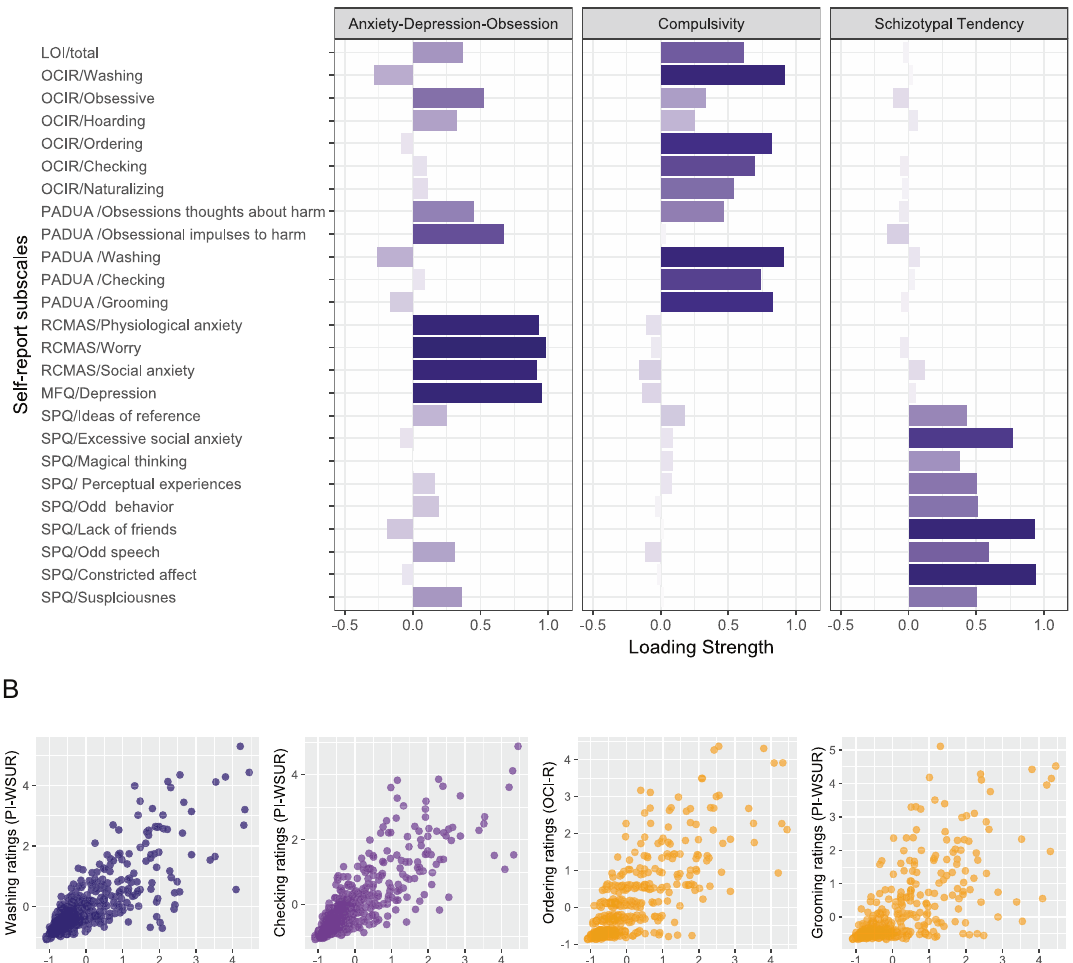
Fig. 1 The three factors revealed from a dimension reduction analysis performed on self-report estimates. A Factor loadings showed that obsessional thinking loaded primarily on the fi rst factor, along with depression, anxiety, and worry subscales. The compulsive behavior subscale primarily loaded on the second factor, and schizotypal tendencies predominantly loaded on the third factor. B Illustration of the association between the compulsive factor and individual items from the self-report measures. The x axis on all four scatter plots indicates the latent score for each individual on the compulsivity factor. The y axis illustrates the subscale score of a single estimate including (from left to right): (I) Compulsive washing (the average rating across the ten items of the washing subscale in the PI-WSUR questionnaire; an example item is, “ I wash my hands more often and longer than necessary. ” ). (II) Compulsive checking (the average rating across the ten items of the checking subscale in the PI-WSUR questionnaire; an example item is, “ I tend to keep on checking things more often than necessary ” ). (III) Compulsive ordering behavior (the average rating across the three items of the ordering subscale in the OCI-R questionnaire; an example item is, “ I get upset if objects are not arranged properly ” ). (IV) Compulsive dressing/grooming (the average rating across the three items of the grooming subscale in the PI-WSUR questionnaire; an example item is, “ I feel obliged to follow a particular order in dressing, undressing, and washing myself ” Eqs. 3 and 4 and Table 1). After fi tting the computational model and the screen, and participants pressed a corresponding left or right response estimating w key to select a fractal (see Fig. 2B). Fractal identity alone, but not their response keys, predicted reward. This task feature was introduced to participants by means of both instruction and practice. We started by re- fi tting a computational model that allows estimation of individuals ’ tendency to assign value to the response key, despite it being outcome- irrelevant [6]. Speci fi cally, Shahar et al. [6] previously reported fi ndings from a comprehensive model comparison using the same data and showed that a tendency to assign and follow outcome-irrelevant representations is captured by two computational model parameters: a decision-weight, re fl ecting the integration of such information during the decision phase ( w outcome-irrelevant ; see Supplementary Information, Eqs. 6 and 7 and Table 1) and a learning-rate parameter, re fl ecting the updating of outcome- irrelevant representations ( α outcome-irrelevant ; see Supplementary Information,